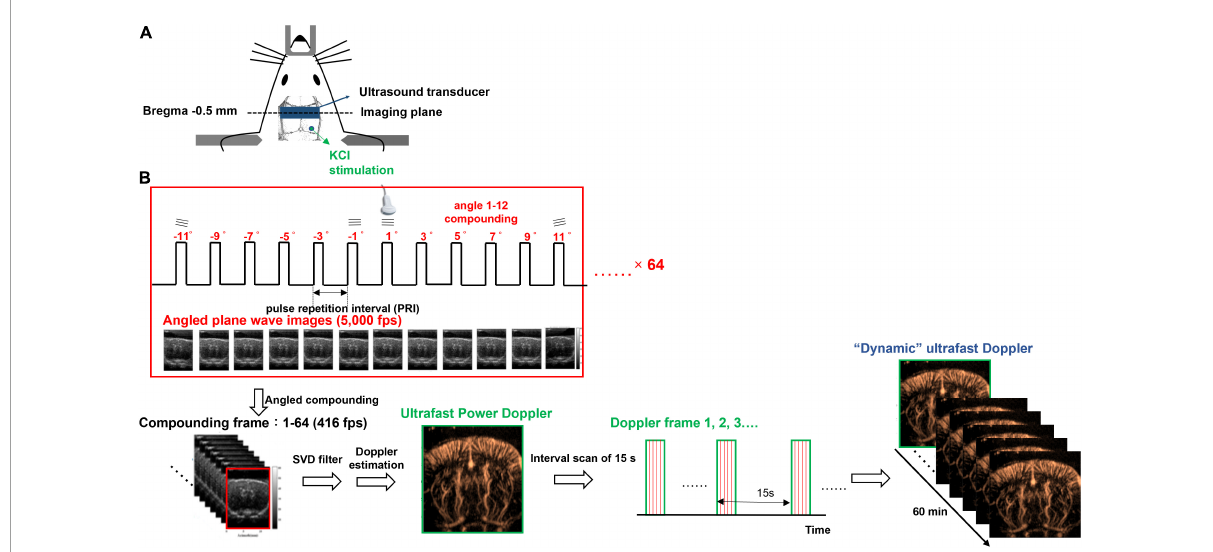
FIGURE1 Experimental setup of dynamic ultrafast Doppler. (A) Schematic illustration of the cranial window, the position of KCl stimulation, and the imaging plane of the transducer. (B) Imaging sequence of dynamic ultrafast Doppler. Twelve angles (from − 11 ◦ to +11 ◦ with a 2 ◦ interval) plane wave imaging was conducted at the imaging frame rate of 5k fps to constitute one compounding image (B-mode), and 64 compounding images were acquired for the generation of one Doppler frame (power/color Doppler image). Time-lapse imaging was acquired by sequential recording dynamic ultrafast Doppler frames with an interval of 15